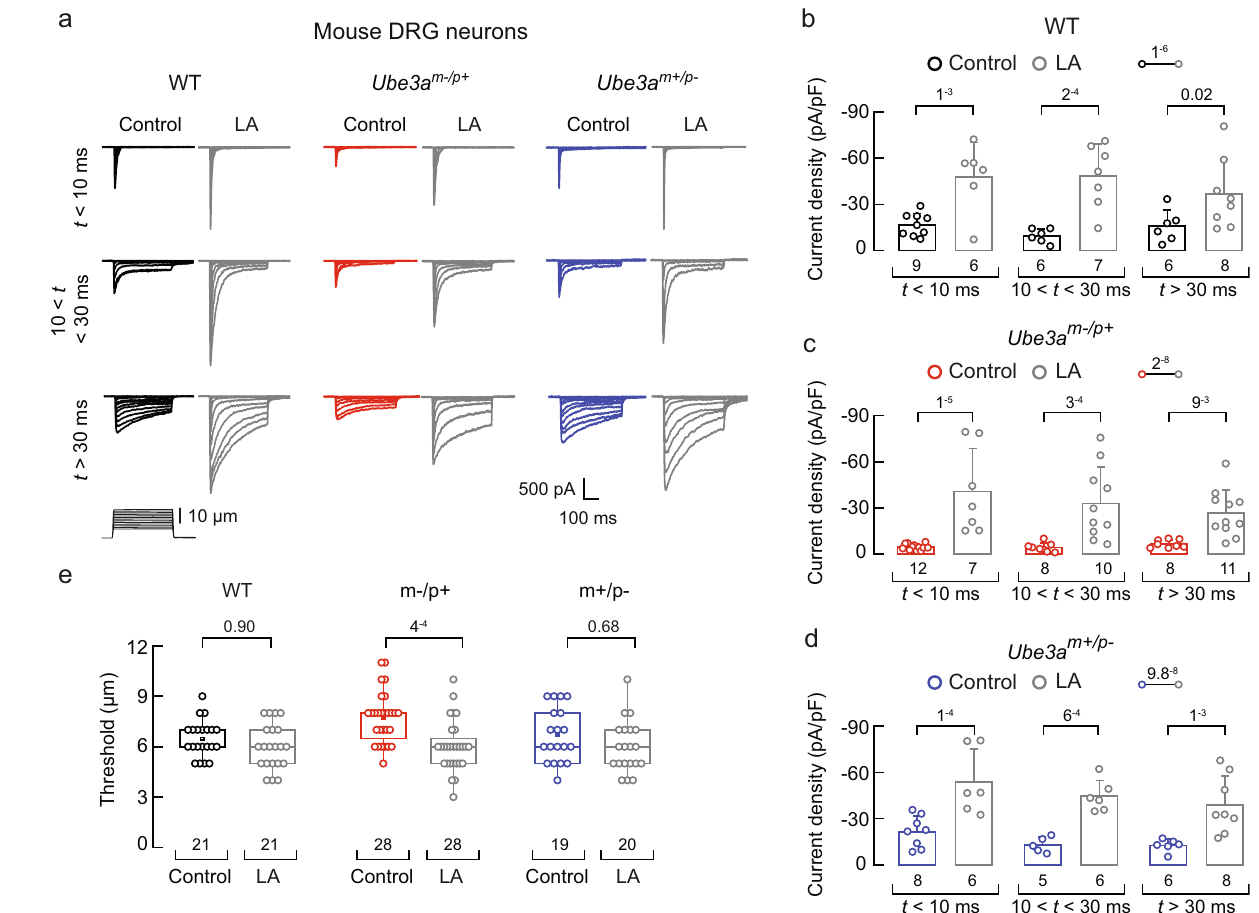
Fig. 6 | LA increases mechanocurrents in Ube3a m – /p+ DRG neurons. a Representative whole-cell patch-clamp recording elicited by mechanical stimu- lation( − 60mV)ofrapidly,intermediate,andslowlyinactivatingcurrentsofcontrol and LA-treated WT, Ube3a m – /p+ , and Ube3a m+/p- DRG neurons. We used a two-day LA supplementation protocol (50 µ M for 24h and 100 µ M for another 24h). b